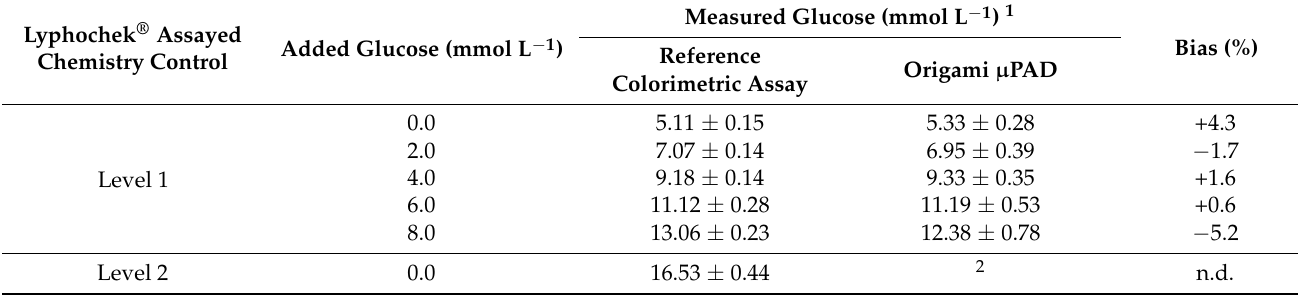
Table 1. Comparison of glucose concentrations measured in non-spiked and glucose-spiked control samples with the origami µ PAD and the reference colorimetric assay. Lyphochek ®